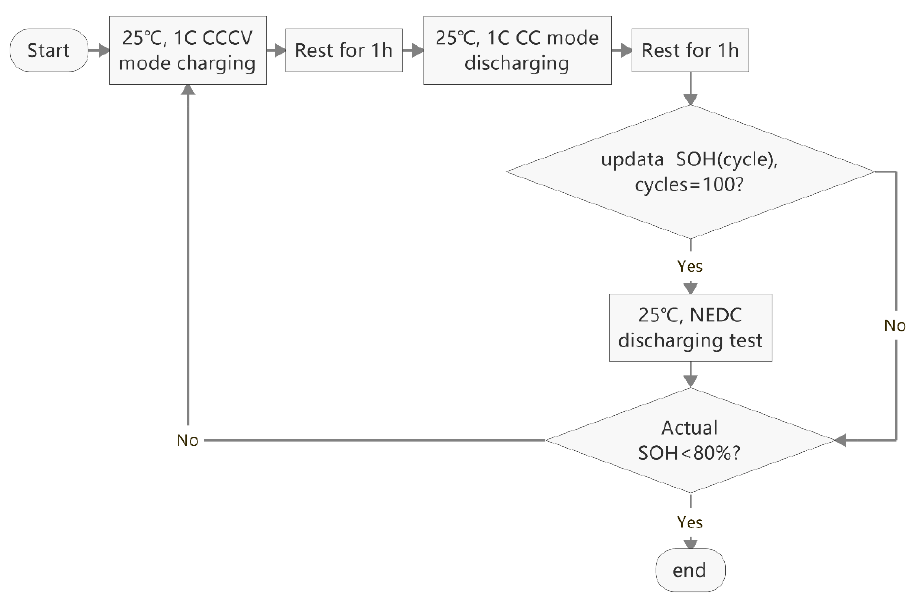
Figure 9. The steps of constant current cyclic aging and NEDC tests.